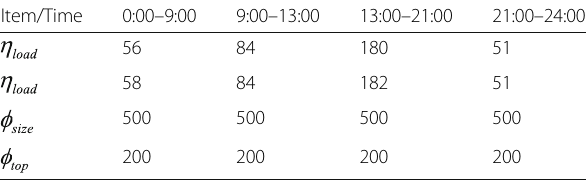
Table 1 Relevant parameters of area